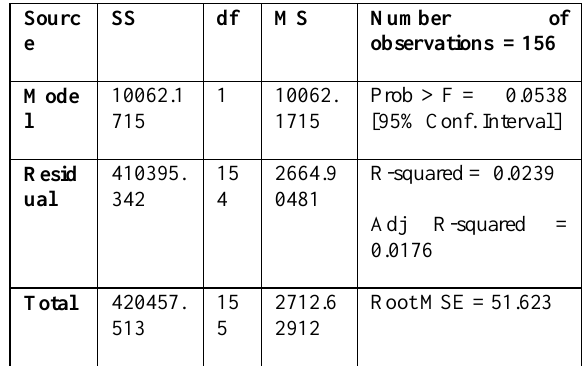
Figure 3: Underserved areas in Kisumu County